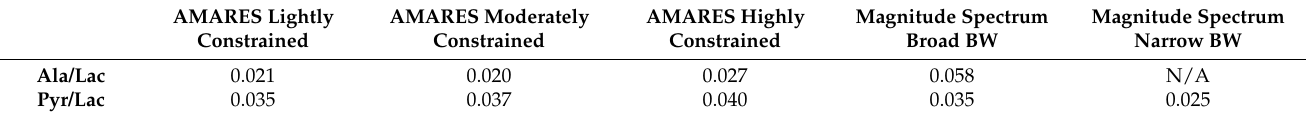
Table 1. Broad bandwidth excited AMARES fit peak amplitudes and broad and narrow bandwidth excited spectral magnitude area under the curve ratios (AUCr) of [1- 13 C]alanine and [1- 13 C]pyruvate over [1- 13 C]lactate (Ala/Lac and Pyr/Lac), summed starting from the frame with the initial appearance of hyperpolarized [1- 13 C]lactate signal to the end of acquired data (frames 32 to 150). Two human pancreatic cancer (PSN1) tumors were each measured with one of the methods. The corresponding data summarized here are also shown in Figures 2 and 3.